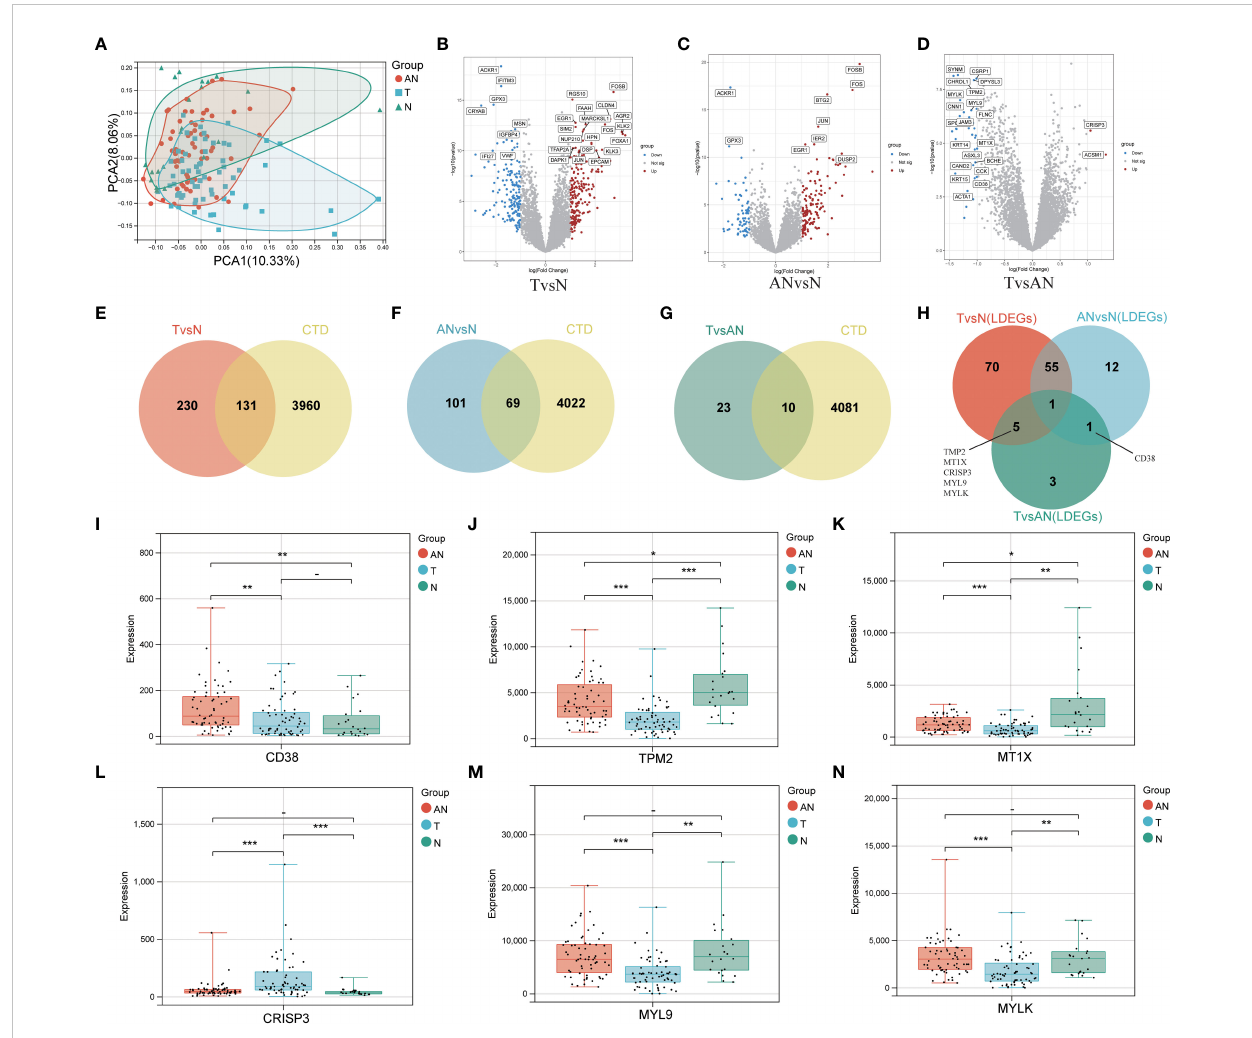
FIGURE 2 To identify differentially expressed LRHG based on GSE68555 dataset. (A) Principal component analysis of GSE68555; (B) DEGs volcano map between tumor and normal; (C) DEGs volcano map between the adjacent normal and normal; (D) DEGs volcanic map between tumor and adjacent normal; (E – G) . Venn diagram, TvsN DEGs in red, ANvsN DEGs in blue, TvsAN DEGs in green, and LPS-related genes obtained from CTD in yellow; (H) TvsN, ANvsN and TvsAN LDEGs Venn diagrams; (I – N) . The expression of CD38 , TPM2 , MT1X , CRISP3 , MYL9 and MYLK in prostate cancer, adjacent normal and normal, * P < 0.05; * * P < 0.01; *** P < 0.001. -: no relevant